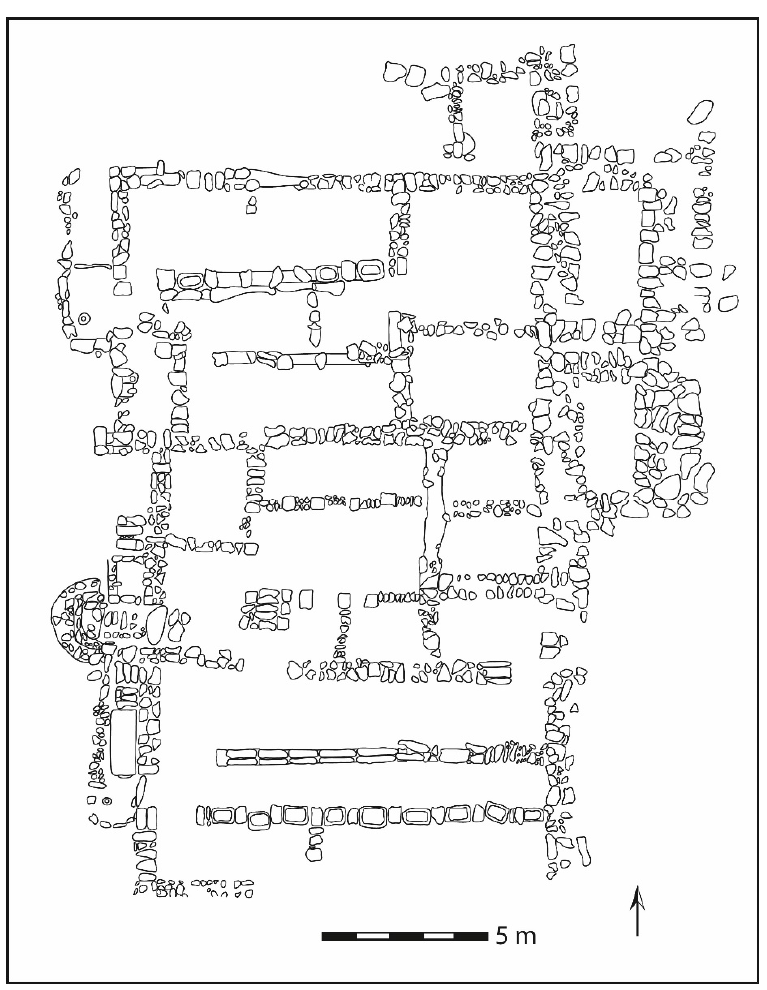
Figure 4. Khirbet al-Mudayna Building 200, B205 and B210 (after Daviau et al. 2012, Fig. 20).